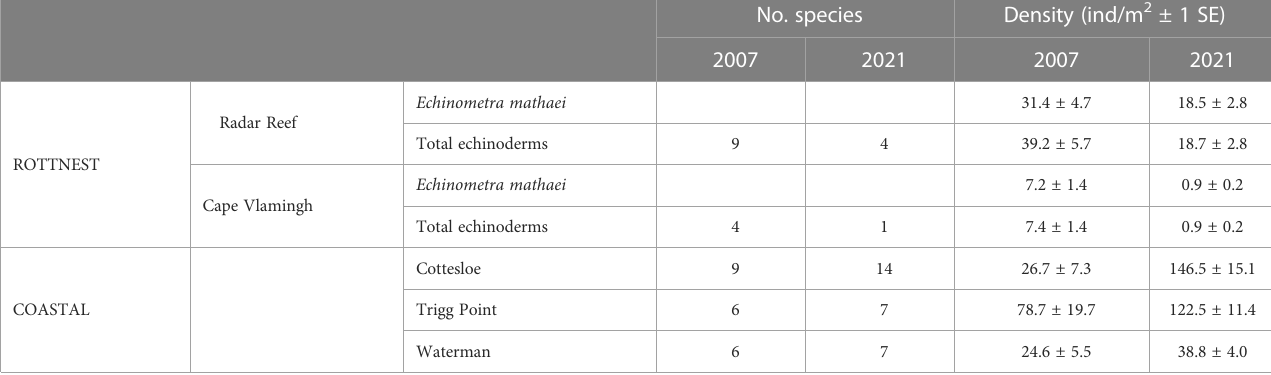
TABLE 3 Diversity and density of echinoderm species identi fi ed on intertidal platforms at Rottnest Island and the Perth coastline, Western